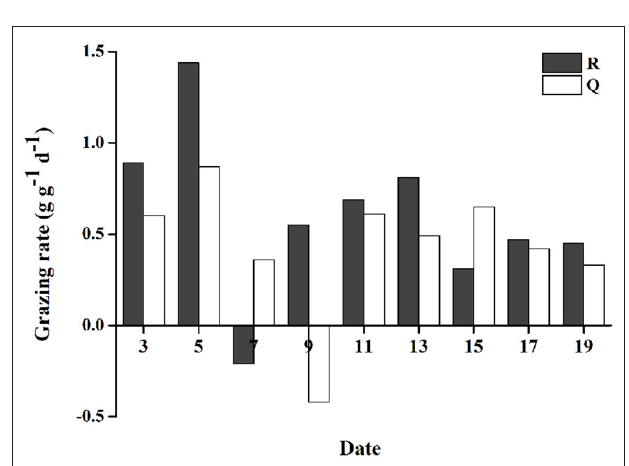
FIGURE 6 | The grazing rate (GR) of Apohyale sp.